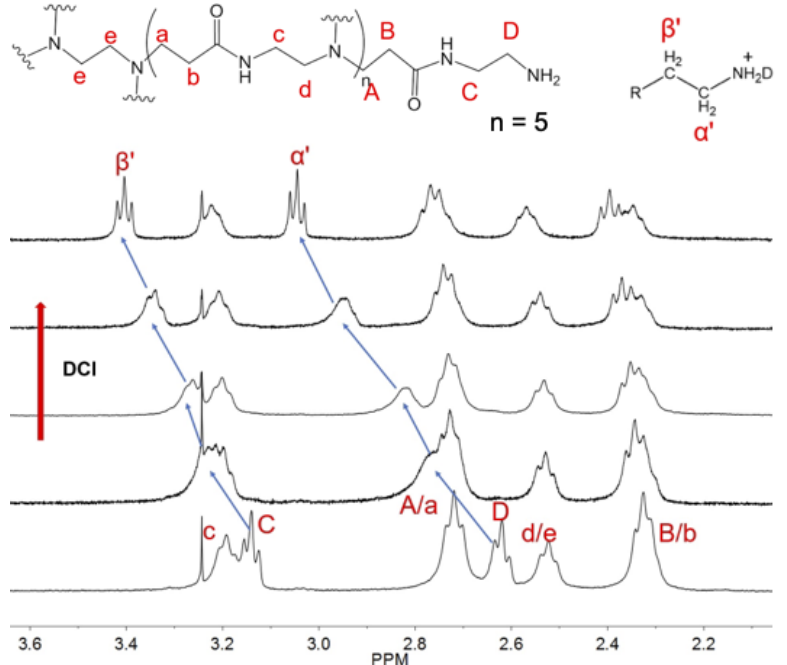
Figure 2. 1 H NMR spectra (400 MHz, D 2 O) of G5 dendrimer upon successive additions of DCl. The